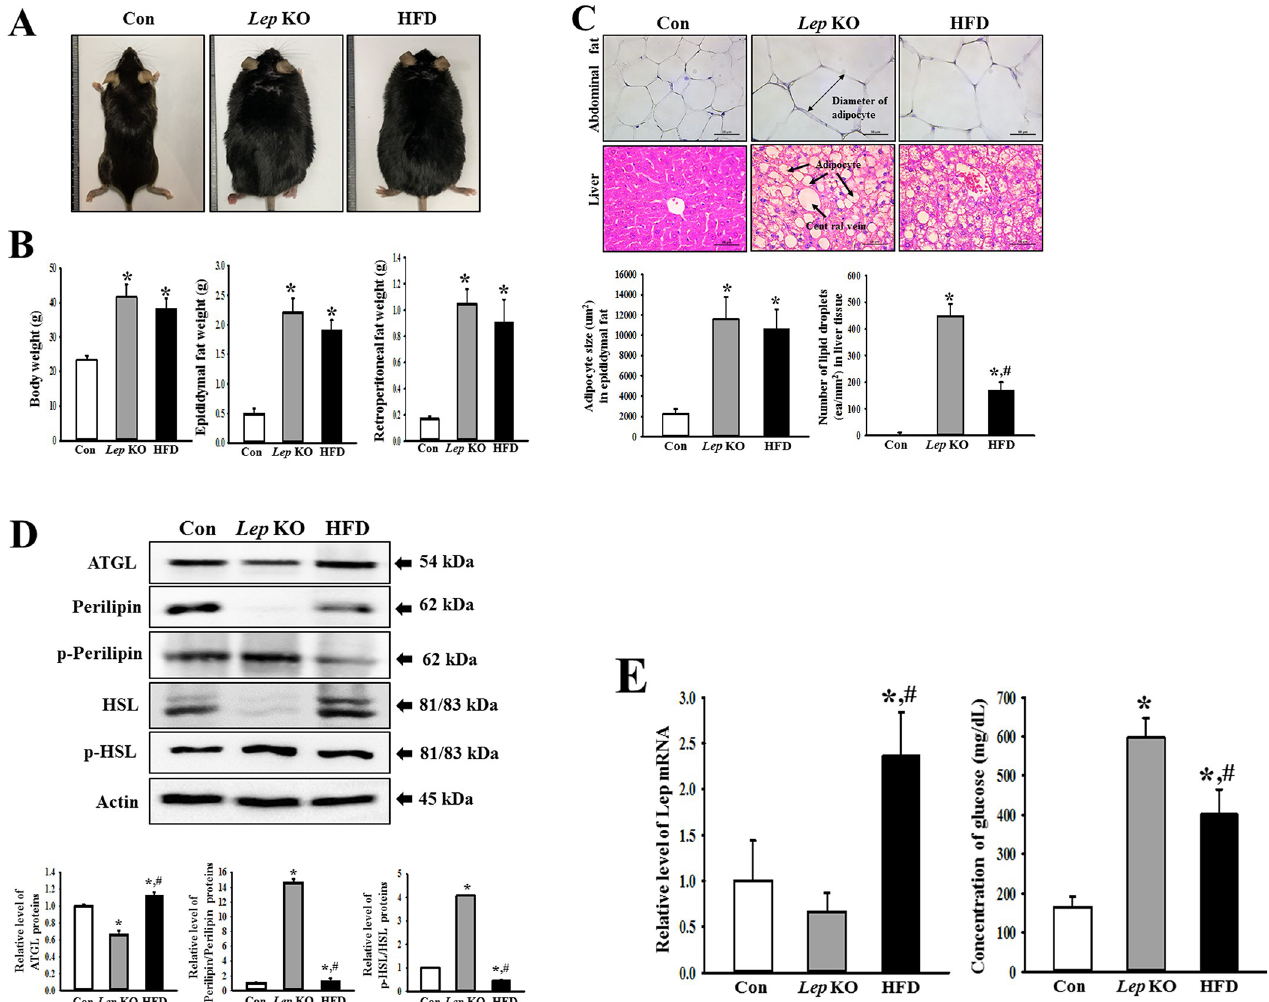
Fig 1. Obesity phenotypes of Lep KO and HFD-treated mice. (A) Morphology of the animals. The animals were photographed using a digital camera after anesthesia. (B) Body and fat weights. Five to six mices were selected from each group, and their weights were assayed in duplicate using an electric balance. (C) Histological structure of fat and liver tissue. After hematoxylin and eosin (H&E) staining of the fat and liver tissue, their histopathological features were observed at 400 × magnification using an optical microscope. The area of each adipocyte in fat and the number of lipid droplets in the liver were measured using the Image J program. Five to six mices per group were used in histological analysis, and each parameter was measured in duplicate on two different slides. (D) Expression of the lipogenic proteins. The levels of ATGL, Perilipin, p-Perilipin, HSL, and p-HSL expression were measured by Western blot analysis using the specific primary antibodies and HRP-labeled anti-rabbit IgG antibody. Three to five mices per group were used to prepare the total tissue homogenate, and Western blot analyses were assayed in duplicate in each sample. (E) Expression of Lep mRNA and glucose concentration. The relative levels of Lep mRNA were determined in the liver tissue using RT-qPCR, while the glucose concentration was measured in the serum of whole blood. The data are reported as the mean ± SD. � indicates p < 0.05 compared to the Con group. Abbreviations: Con, Control group; Lep KO, Leptin knockout mice; HFD, High fat diet; ATGL, Adipose triglyceride lipase; HSL, Hormone-sensitive